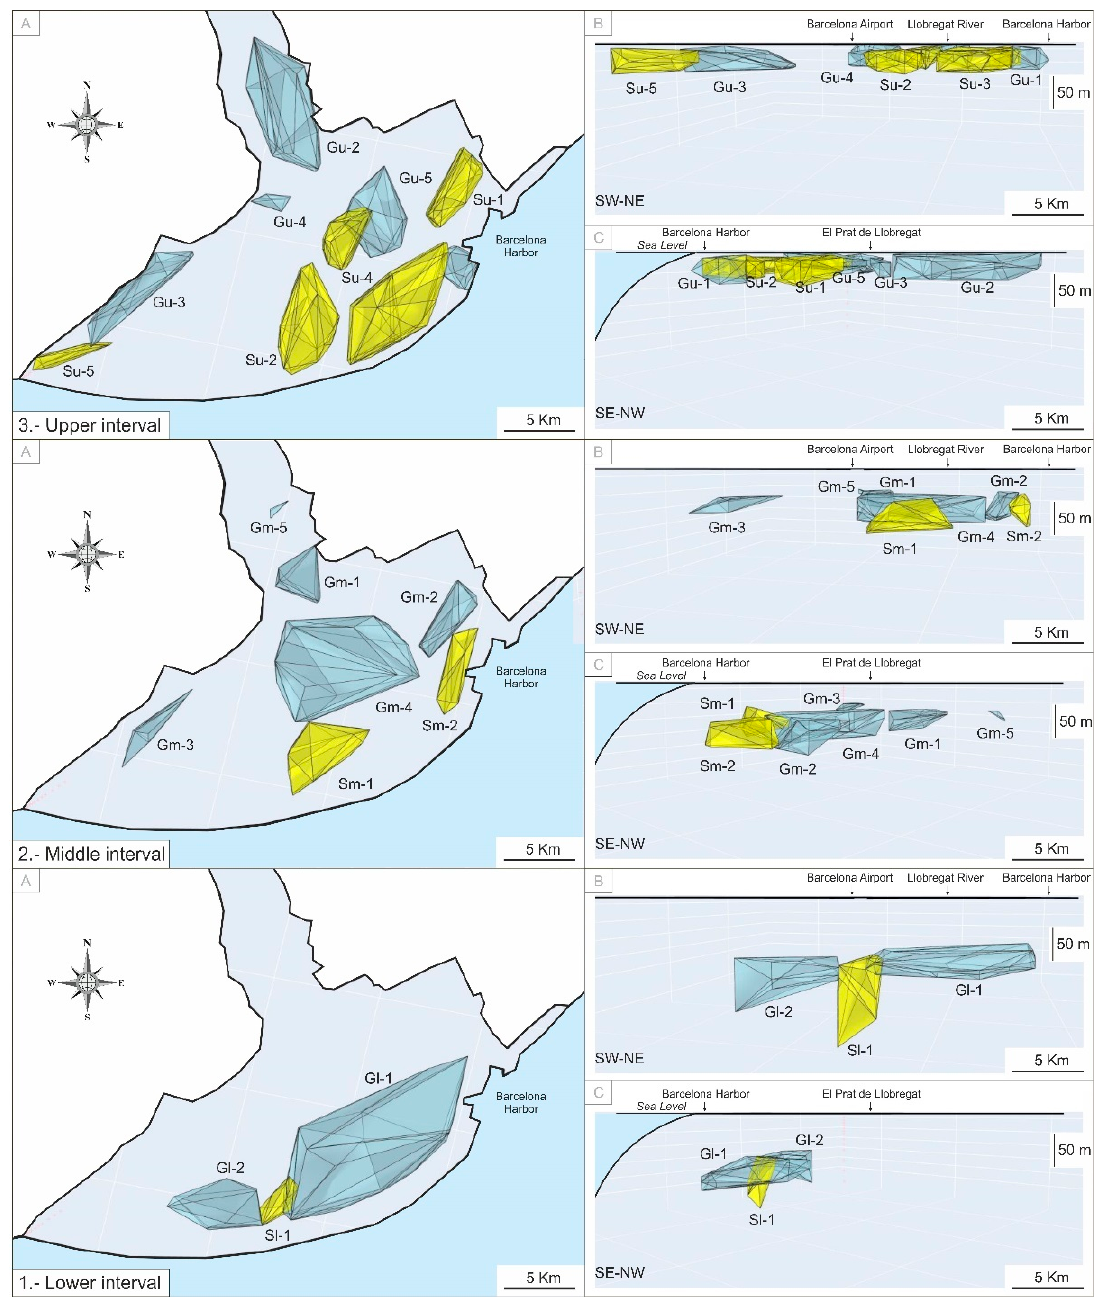
Figure 9. Zenithal ( A ), SE–NW frontal ( B ), and NE–SW lateral ( C ) views of the gravel (G) and coarse sand (S) lithosomes within the LRD lower (l), middle (m), and upper (u) intervals. The plotting adopted a 1:1:50 (x = 2, y = 2 and z = 0.5) aspect ratio for better display. The color assigned to each lithesome is cyan for gravel and yellow for coarse sand. An interactive 3D HTML version of this model is provided as supplementary material